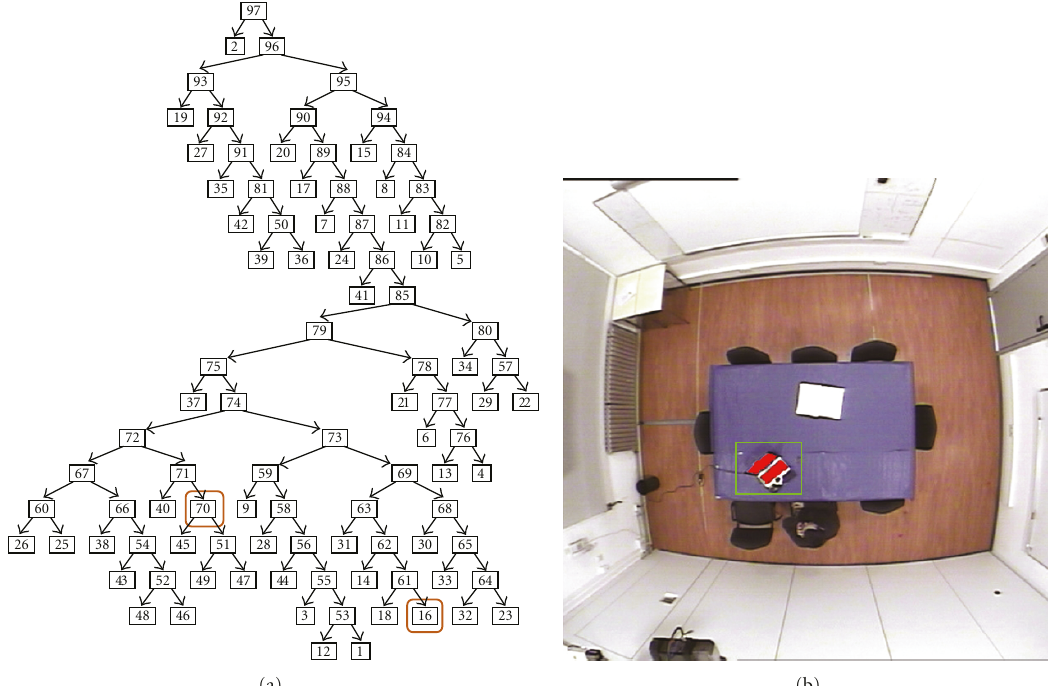
Figure 5: Object detection. In (a), the binary tree representing the whole image as a hierarchy. Regions corresponding to the screen and keyboard regions are identified within the tree. In (b), the detection of a laptop from zenithal view.